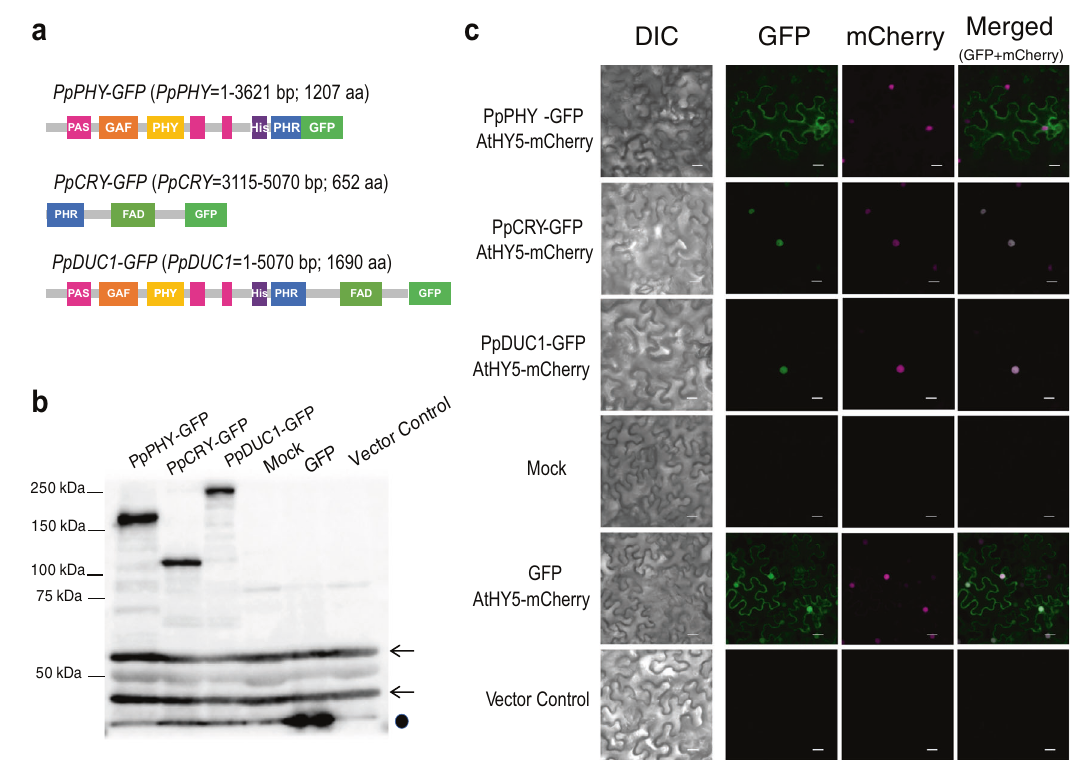
Fig. 3 Subcellular localization of PpDUC1 in tobacco leaves. a Schematic diagrams of the domains in the PpPHY, PpCRY and PpDUC1 constructs used in the N. benthamiana leaf injection assay. b Immunoblot images of protein extract from N. benthamiana leaf tissue. Each protein was detected using an α -GFP antibody. Mock, non-injected leaf. Black arrows denote non-speci fi c bands. Dot indicates the dye front. Experiments were repeated two times, and the results of one representative experiment are shown. c Leaf injection assay in N. benthamiana pavement cells transiently expressing PpPHY-GFP, PpCRY- GFP and PpDUC1-GFP with HY5-mCherry to indicate the nucleus. Observations were performed three times with similar results. DIC, differential interference contrast images; GFP, GFP fl uorescence images; Merged, merged images of GFP and mCherry fl uorescence images. Scale bar = 20 μ m. The source data underlying Fig. 3b are provided as a Source Data fi